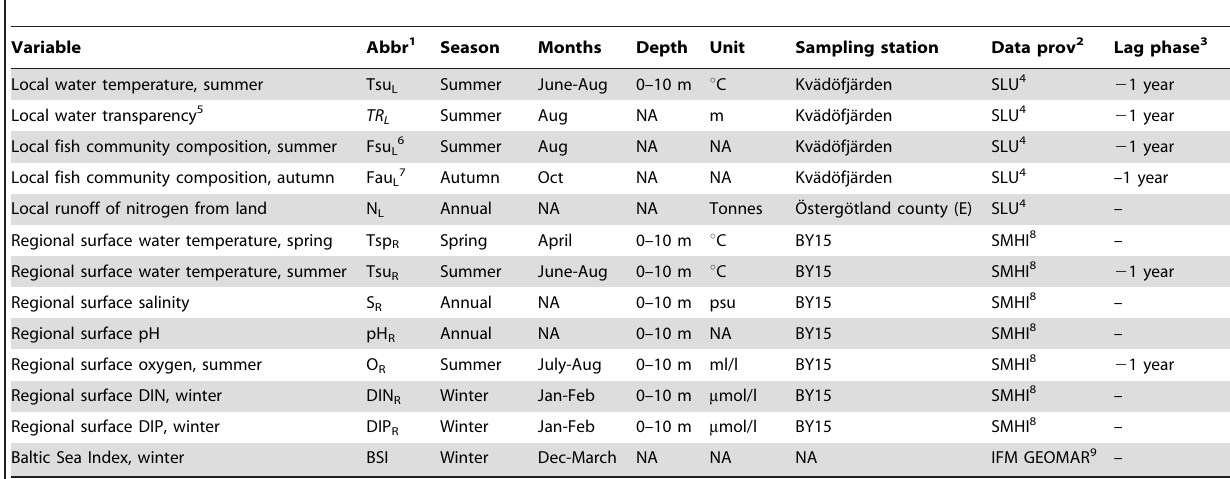
Table 2. The variables used as predictors for the temporal development of zoobenthos communities in Kva¨do¨fja¨rden.